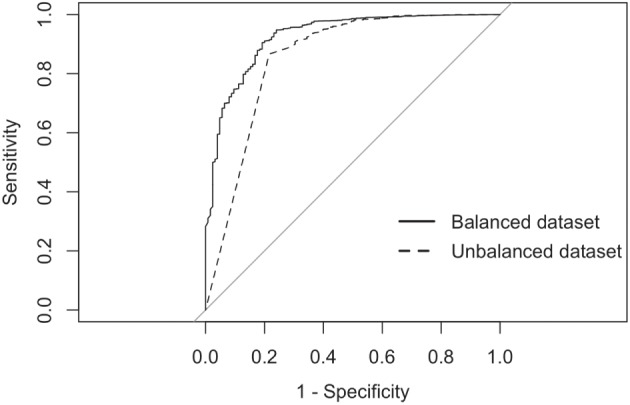
Receiver-operating characteristic curves for the RF analyses using balanced and imbalanced datasets.